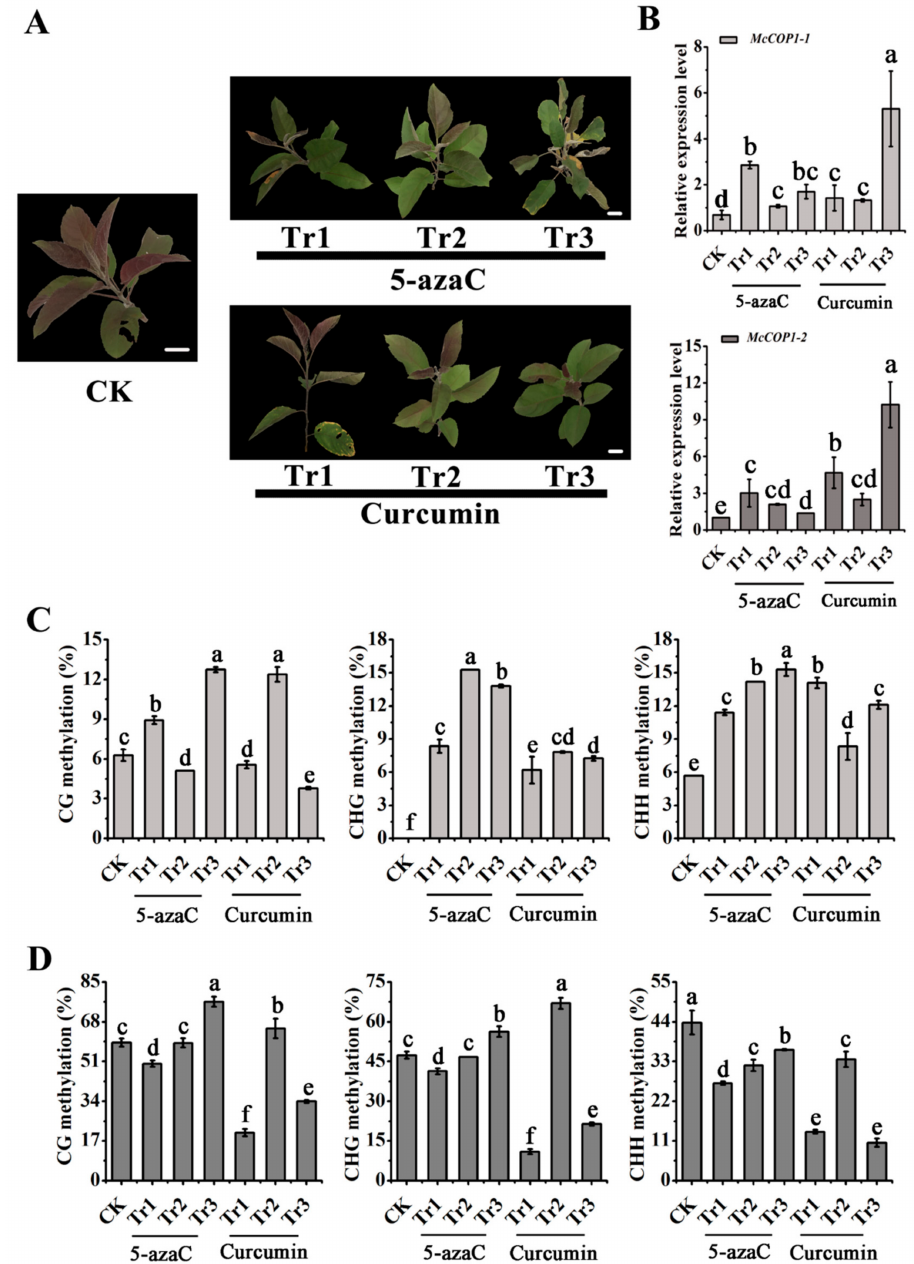
Figure 3. The effect of the 5-azacytidine and curcumin methylation inhibitors on McCOP1 transcrip- tion in ‘Radiant’ leaves. ( A ). Leaf phenotypes after 5-azacytidine (5-azaC) and curcumin treatment. ( B ). Relative McCOP1-1 and McCOP1-2 expression. ( C ). McCOP1 promoter methylation level deter- mined using BP1 primers. ( D ). McCOP1 promoter methylation level determined using BP2 primers. The concentrations of DNA methylation inhibitors were 0 (CK), 0.1 (Tr1), 1 (Tr2), 10 (Tr3) µ mol · L − 1 . Bars = 2 cm. Real Time (RT)-quantitative (q) PCR and methylation assays were performed with three biological replicates. Error bars indicate the standard error of the mean ± SE of three replicate measurements. Different letters above the bars indicate significantly different values ( p < 0.05), calculated using one-way analysis of variance (ANOVA) followed by a Duncan’s multiple range test. Scale bar = 1